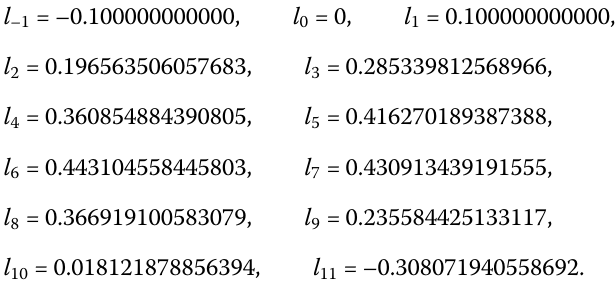
Figure 3 Comparison of exact and cubic-B solution for Problem